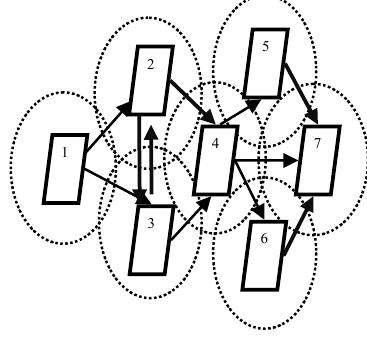
Figure 3. Network Scenarios for Flooding